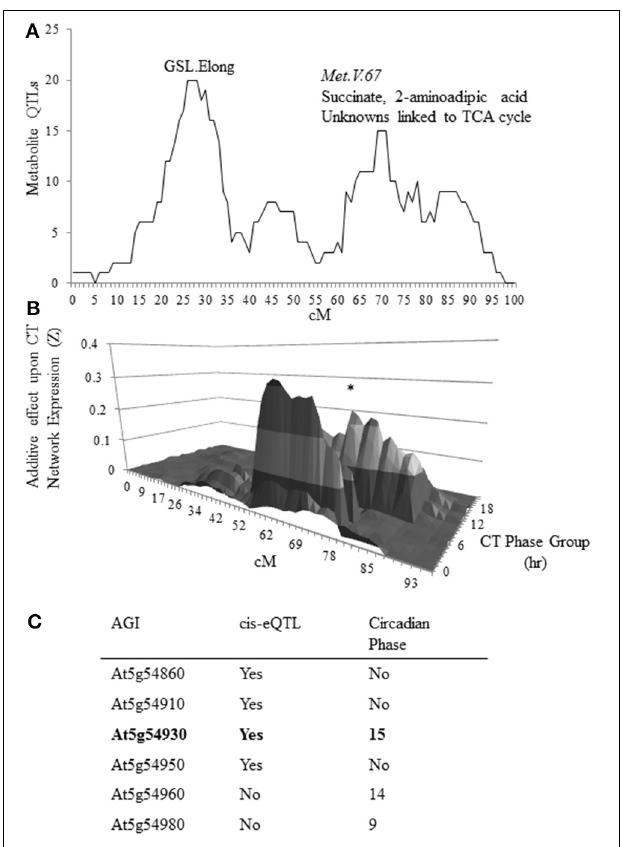
FIGURE 1 | Candidate identification for metabolomics QTL MET.V.67. (A) The number of metabolites for which a QTL was detected in the Bay × Sha RIL population on chromosome V within a 10cM sliding window is shown. The permuted threshold ( P = 0.05) for detection of a significant metabolite hotspot within this analysis is 12 metabolite QTLs. The X axis shows the chromosomal position in cM. The known metabolomics QTLs on chromosome V are labeled as GSL.Elong and Met.V.67 with the known chemicals listed above the peak. (B) Shown is the impact of natural variation on chromosome V in the Bay × Sha RIL population upon expression of circadian CT phase group networks from previously published data. Each CT phase group consists of the genes that have a peak of circadian expression within 30min of the time for that group. The graph presents the predicted additive effects across chromosome V for each CT phase group’s expression from CT0 to CT23. The asterisk marks the CT phase group that is most impacted at the Met.V.67 locus (CT15).The bottom shows the position on the chromosome in cM. (C) Shown is the list of candidate genes in the 3-LOD interval for the metabolomics QTL Met.V.67 (At5g54830 to At5g55040) that have either a cis -eQTL or are regulated in a circadian manner with the phase